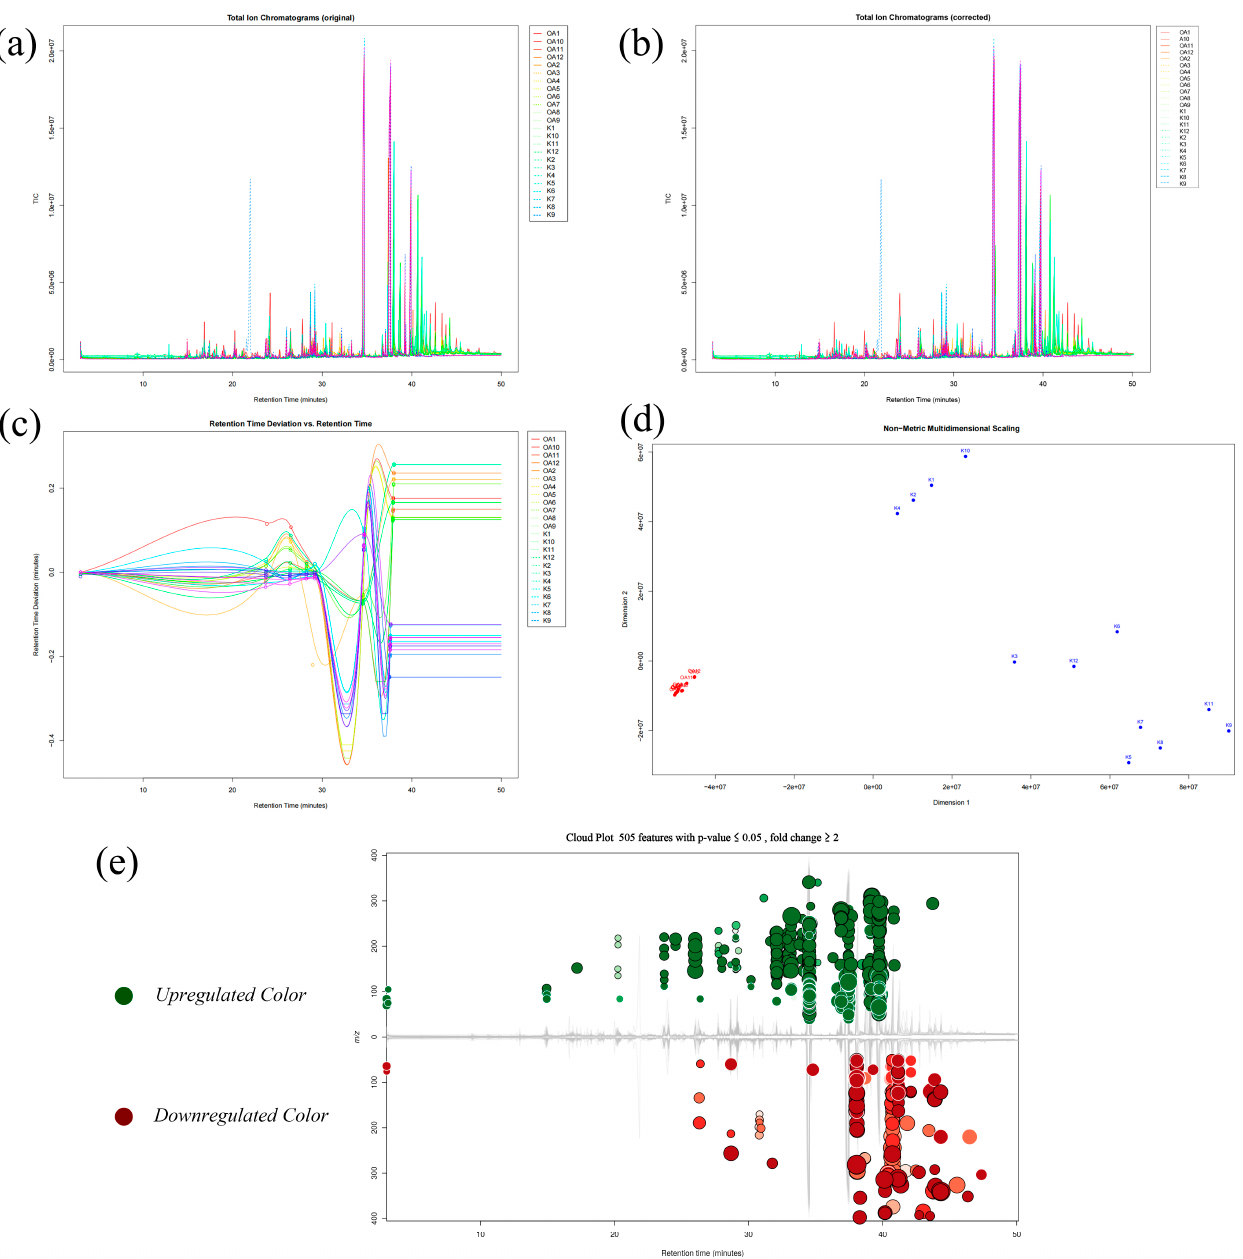
Figure 4. Overview of the results of untargeted GC-MS analysis of the metabolic profiles of all samples by XCMS-Online. The overlap of total ion chromatograms (TIC) before ( a ) and after ( c ) retention time (RT) alignment, the retention time alignment curve ( b ), multidimensional scaling ( d ), and differential feature plot (“mirror plot”) ( e ). The red indicated the features that is more highly expressed in the GKA, and the green represented the opposite. p value is represented by how dark or light the color is. Fold change is represented by the radius of each feature.